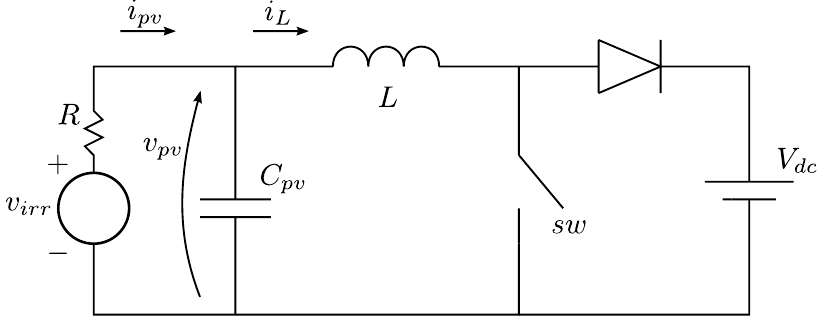
Figure 6. Circuit model of a DC/DC boost converter for applications in PV systems.